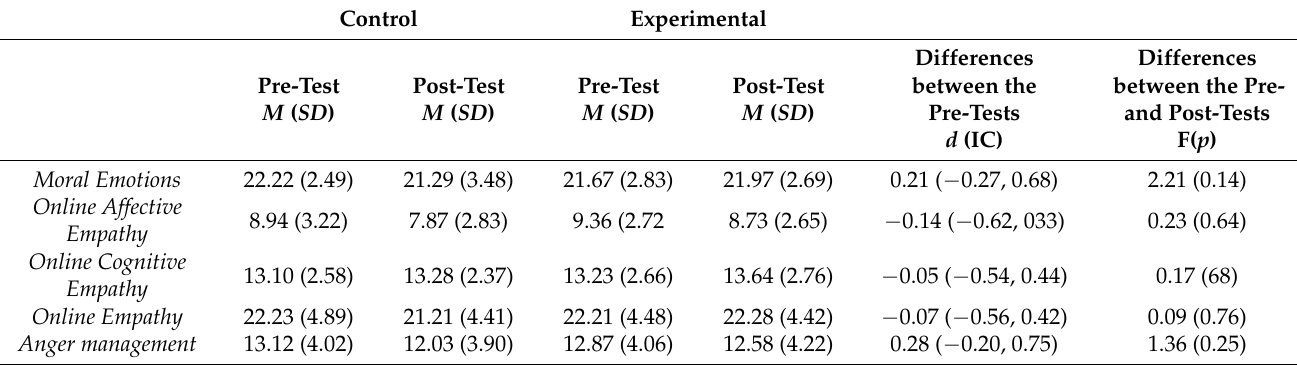
Table 6. Differences in pre-and post-test scores in moral emotions , anger management , and online empathy in boys.